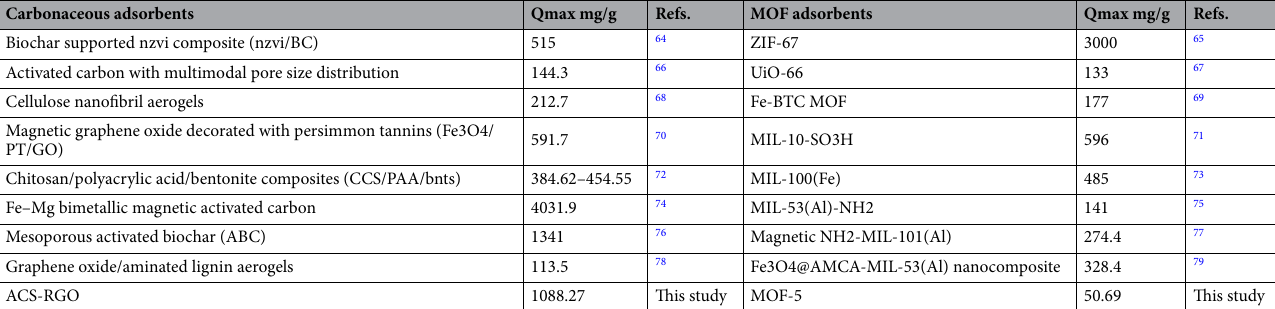
Table 4. Comparison of qmax for MG for carbon-based and MOF-based adsorbents.